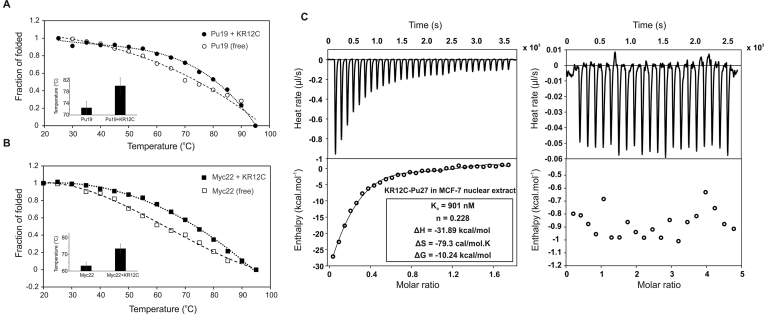
Conformer selectivity and stabilizing effect of KR12C for wild-type Pu27 and its different loop isomers. (A, B) CD melting curves of Pu19 and Myc22 with and without KR12C peptide. Bar plots indicate escalation of the melting temperature (Tm) of Pu19 and Myc22 upon KR12C interaction. (C) Isothermal titration calorimetry showing intermolecular interactions between KR12C and Pu27 under macromolecular crowding conditions provided by MCF-7 nuclear extract (left). Top panels: enthalpic heat released versus time at 25°C during titrations. Bottom panels: thermogram of the integrated peak intensities plotted against the molar ratio of the complex. Best-fit curves using single-site binding model. Thermodynamic parameters of binding reactions and binding affinity of KR12C for Pu27 under macromolecular crowding conditions are provided. Binding isotherm is subtracted from the background titrations; i.e., oligonucleotides into MCF-7 nuclear extract (Right).